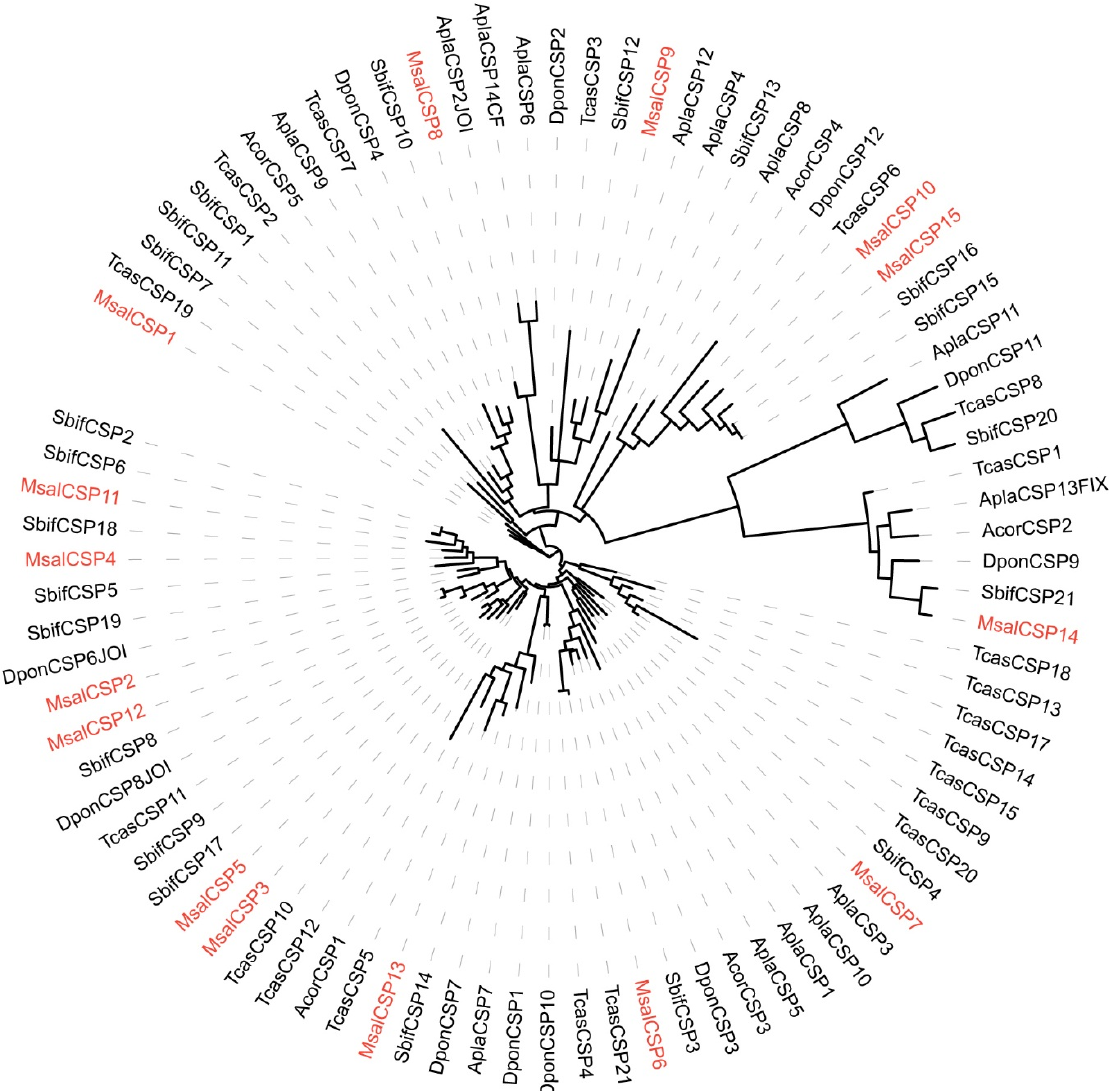
Figure 4. Maximum likelihood dendrogram based on protein sequences of candidate chemosensory genes (CSP) in M. saltuarius and orthologs from other Coleopteran insects. LG + I + G4 model based on the best fit result of IQ-tree model finding, and bootstrap consensus tree inferred from 1000 replicates were used. Monochamus saltuarius (Msal) (red), Semanotus bifasciatus (Sbif), Tribolium castaneum (Tcas), Anomala corpulenta (Acor), Agrilus planipennis (Apla), and Dendroctonus ponderosae (Dpon).